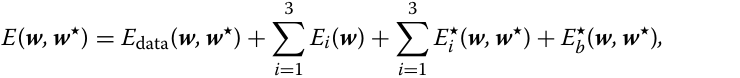
The set of original weights and biases of the PINN denoted by w is then